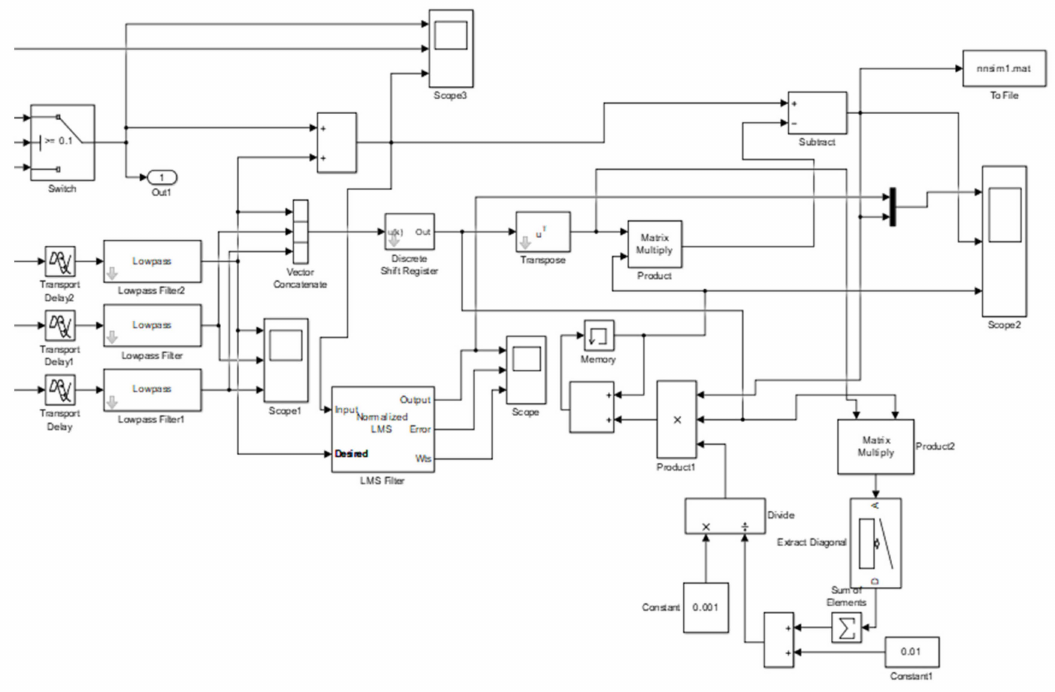
Figure A1. Simulink diagram for noise cancellation using normalized least mean square technique Energies 2020 , 13 , x FOR PEER REVIEW 28 of 31 (NLMS).